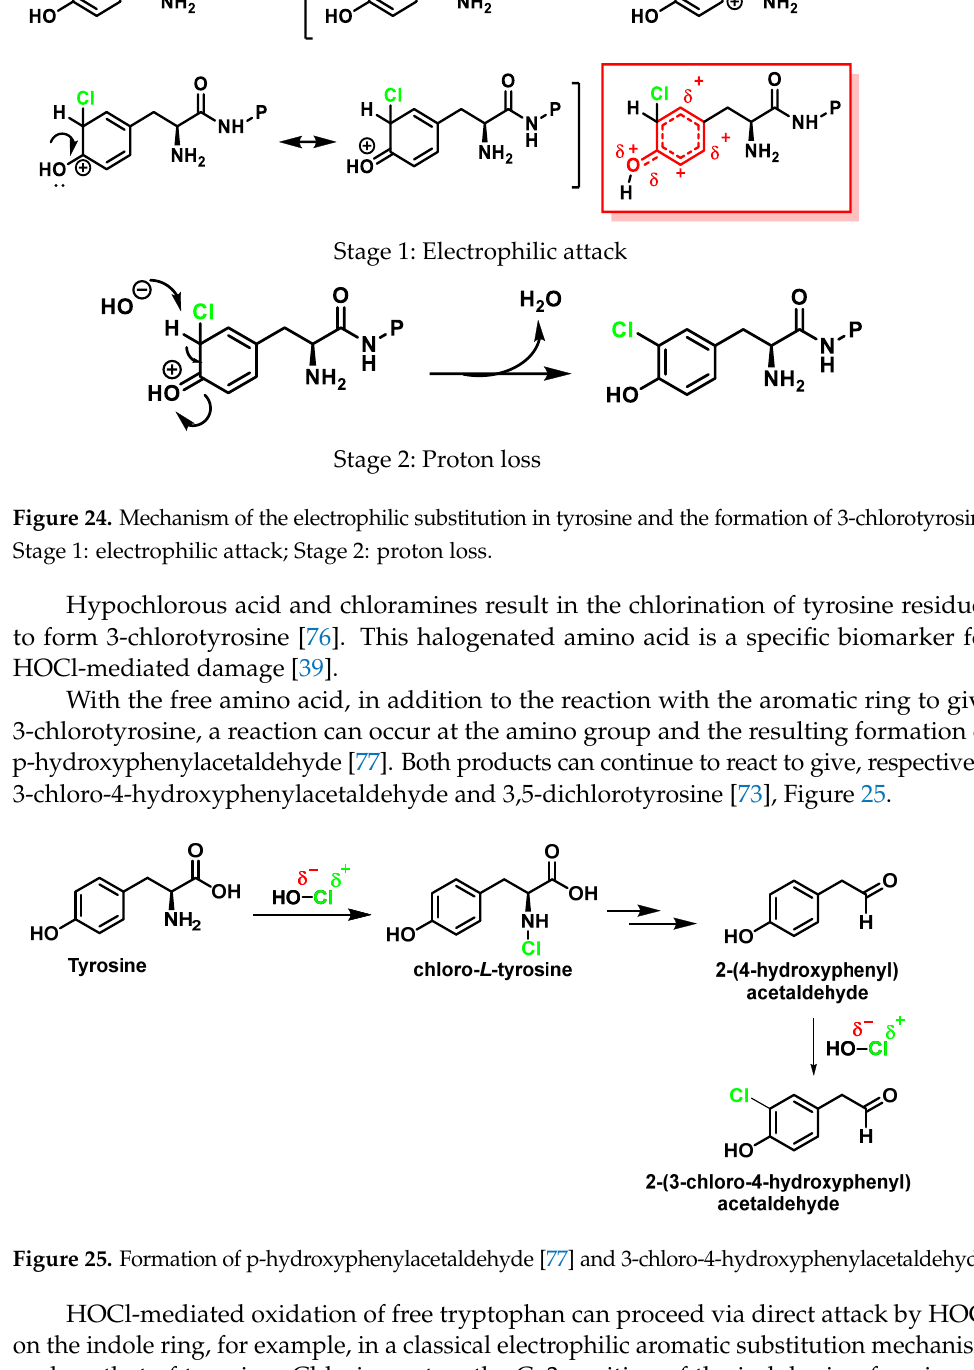
17 of 46 Figure 23. Reaction of P-protected tyrosine with HOCl and formation of 3-chloro- and 3,5-dichloro- tyrosine derivatives. Direct HOCl attack and a chlorine transfer from the chloramine initially produced in the amino group of the amino acid are the two mechanisms proposed for the chlorination